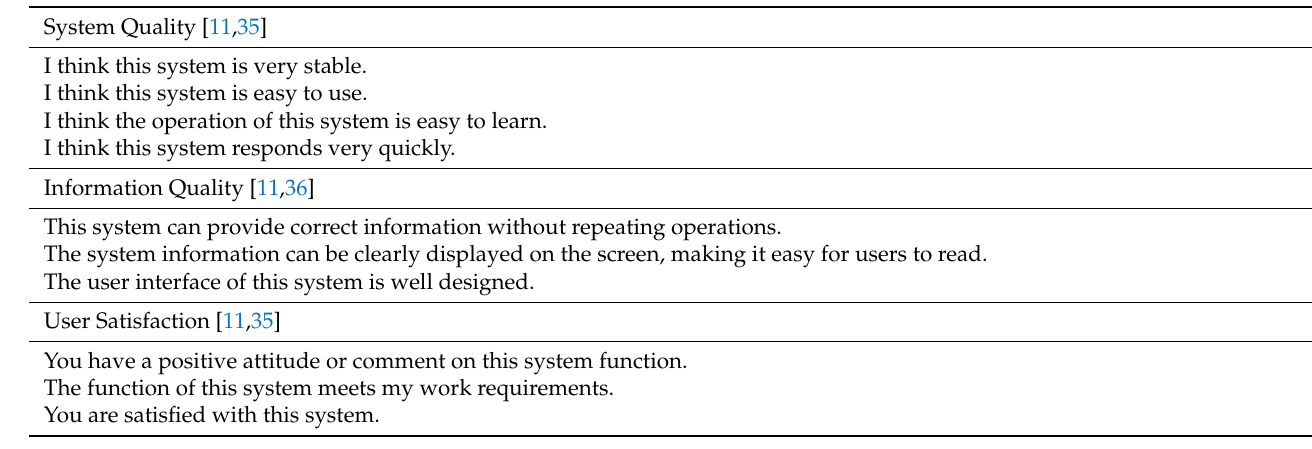
Table A1. Items of the questionnaire for volunteers.